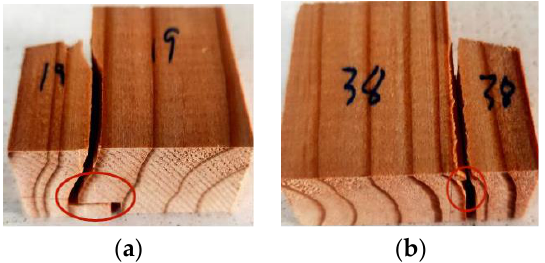
Figure 3. Failure patterns extending to different growth rings. ( a ) Sample 19 with wide rings. ( b )